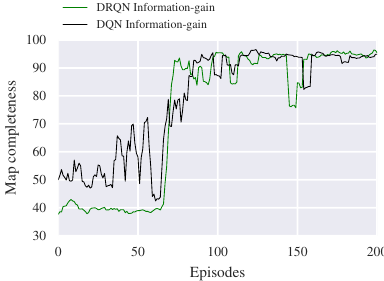
Figure 3: Comparison of training performance of DQN and DRQN when the ”information-gain” reward function (9) is employed.